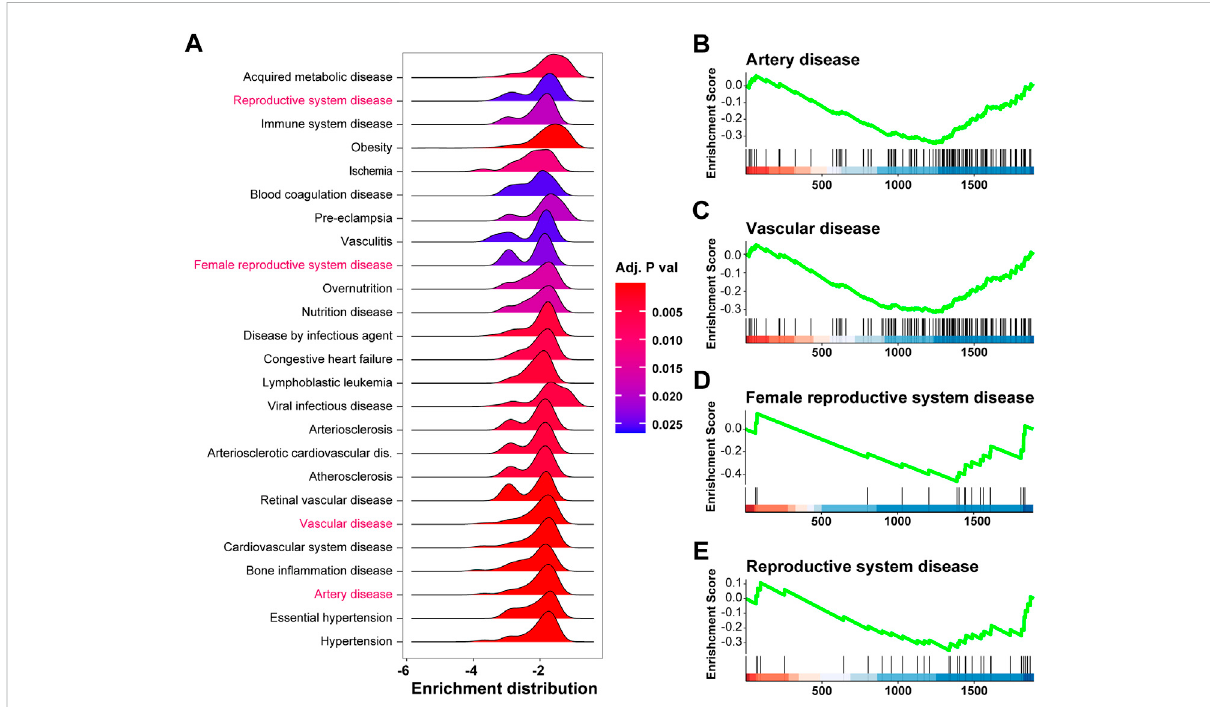
FIGURE 4 Disease enrichment analysis of differentially expressed genes in pre-eclampsia. The disease enrichment analysis and gene set enrichment analysis (GSEA) were conducted based on the expression pro fi le of the 1,891 differentially expressed genes. (A) Ridge plot showing items related to immune response, reproduction, and vascular diseases in disease enrichment analysis. (B – E) GSEA plot showing the enrichment result of pre- eclampsia (B) , vasculitis (C) , vascular disease (D) , and female reproductive system disease (E)